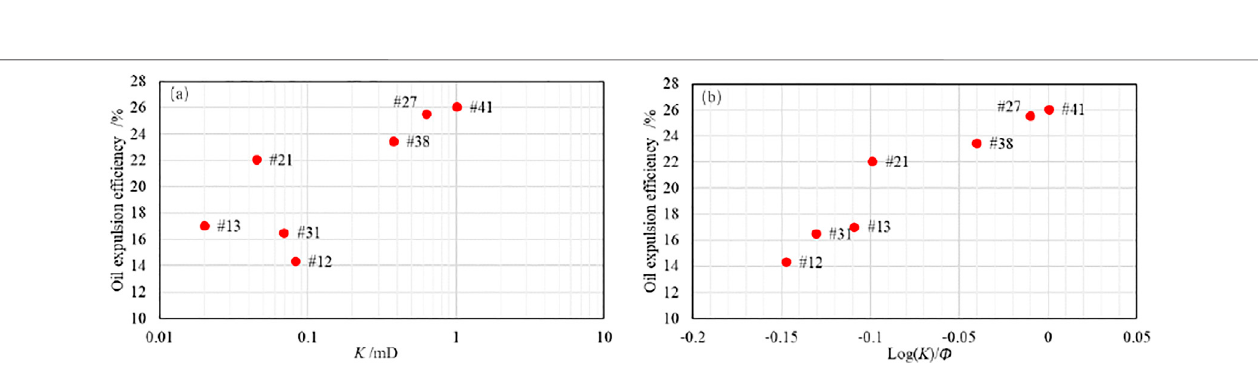
Frontiers in Energy Research |